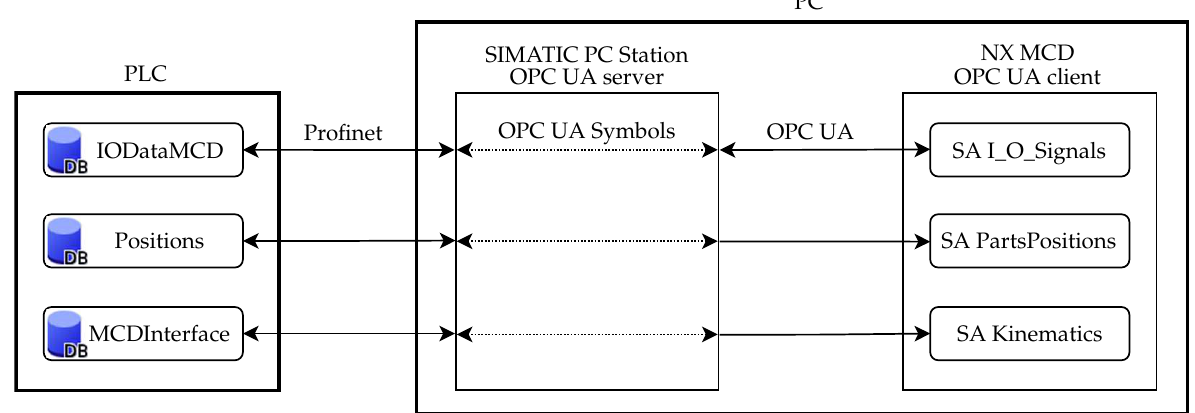
Figure 8. Communication structure between PLC, PC Station and NX MCD.